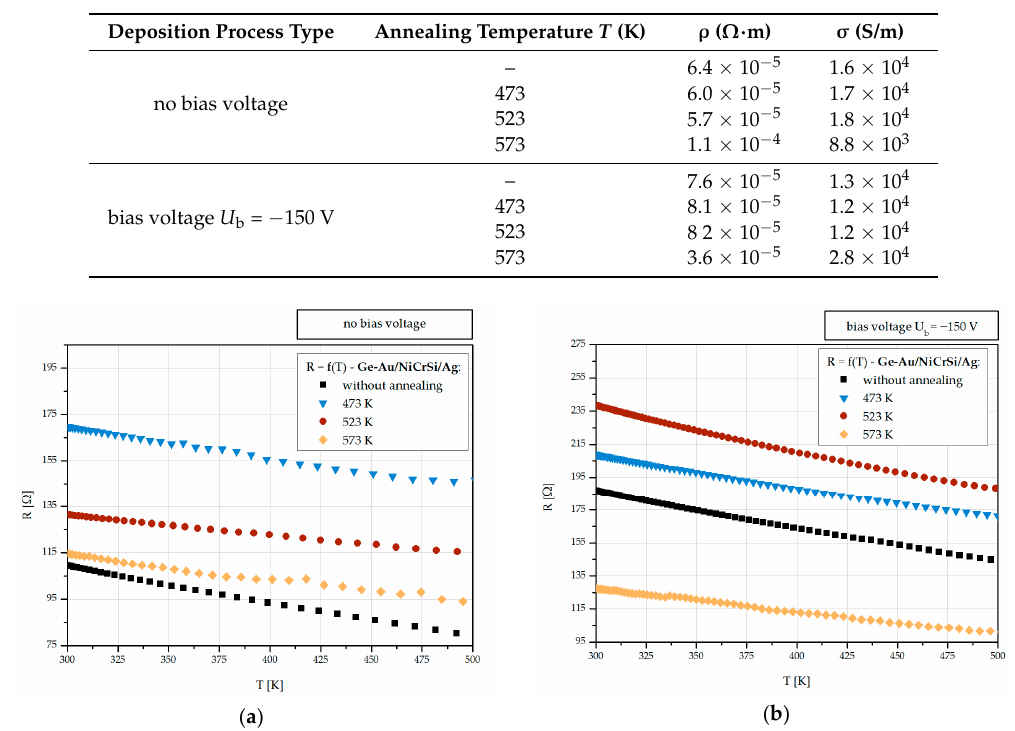
Figure 4. The resistance R as a function of the structure’s temperature T before and after annealing: ( a ) Ge–Au/NiCrSi/Ag test structures deposited in the sputtering process without external bias voltage; ( b ) Ge–Au/NiCrSi/Ag test structures deposited in the sputtering process with external bias voltage.